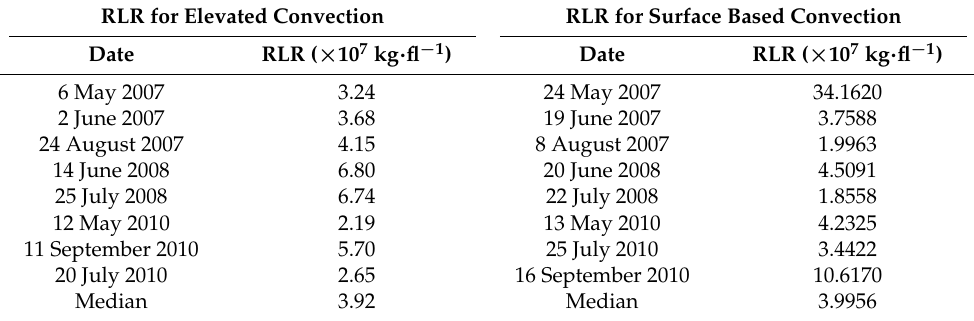
Table 2. RLR values for elevated convection events (left) and surface based convection events (right) within the heavy rain